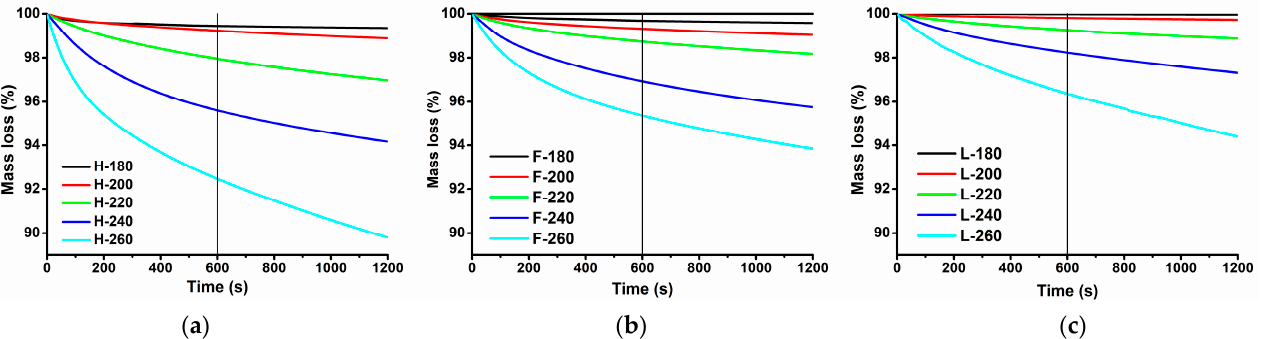
Figure 2. Mass loss of fibres as a function of time during the isothermal TGA measurements at different temperatures: ( a ) hemp fibres; ( b ) flax fibres; ( c ) Lyocell fibres.